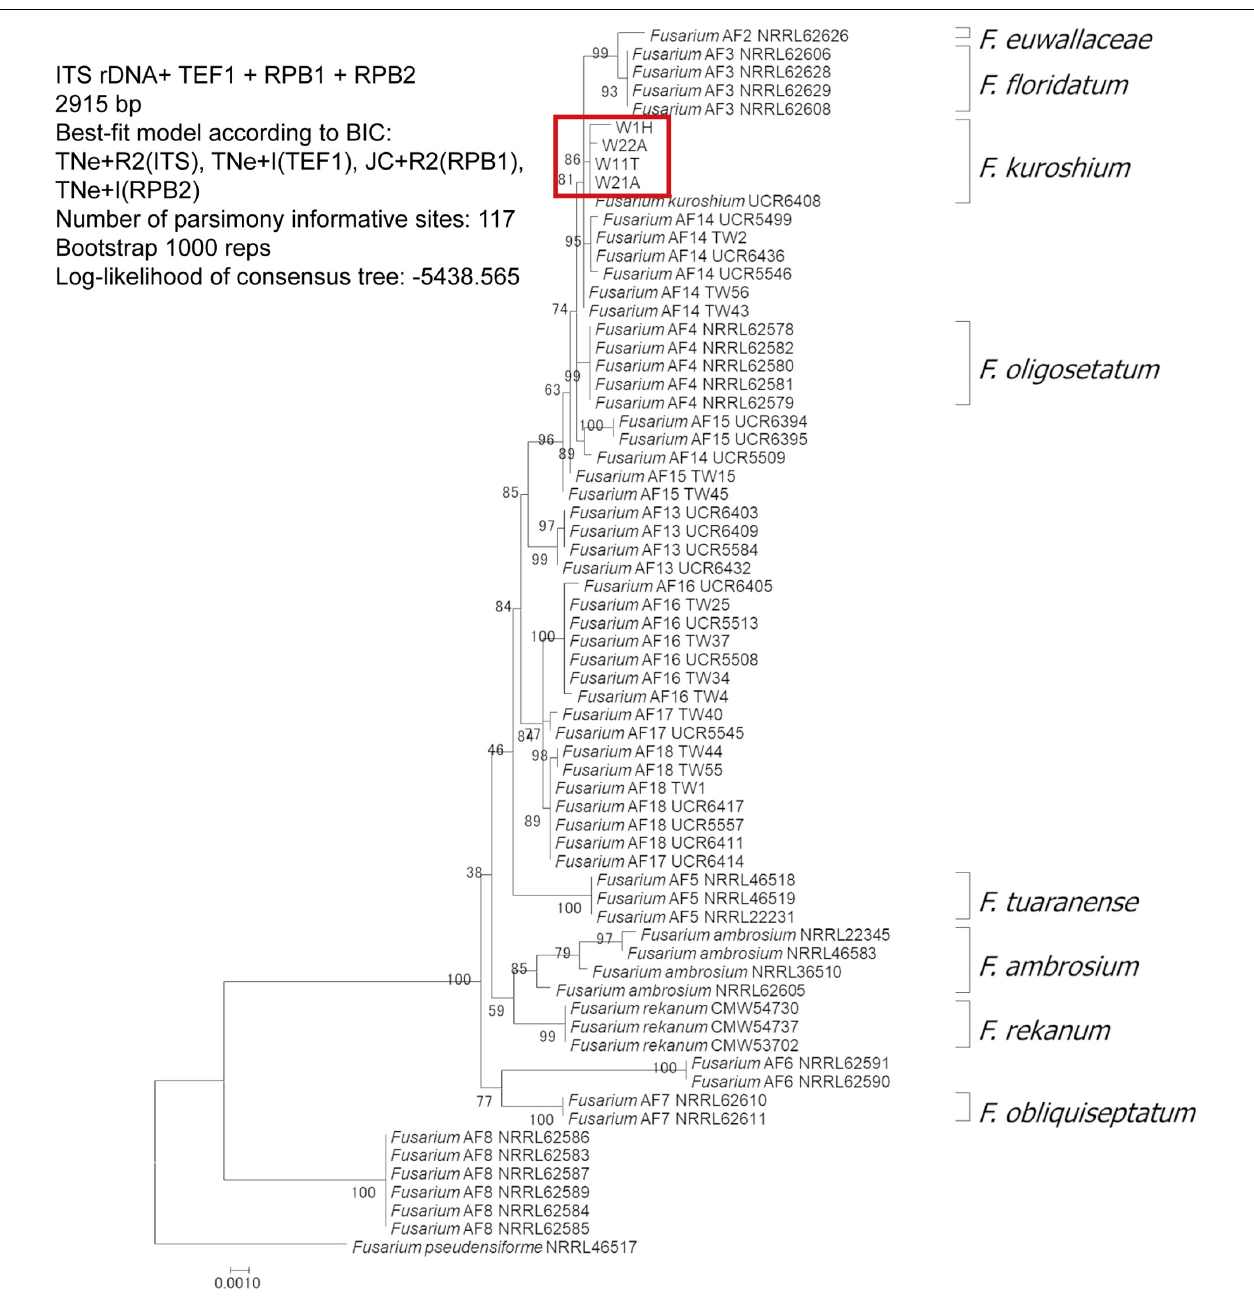
FIGURE 3 | Multilocus phylogenetic analysis of ambrosia Fusarium clade conducted with four genes: ribosomal internal transcribed spacer, elongation factor 1- α , DNA-directed RNA polymerase II largest subunit, and DNA-directed RNA polymerase II second largest subunit. The diagram was constructed using IQ-TREE maximum likelihood method bootstrapped with 1,000 replications. The red box indicates the phylogenetic placement of the Fusarium species associated with Euwallacea interjectus distributed in Hiroshima Prefecture, Western